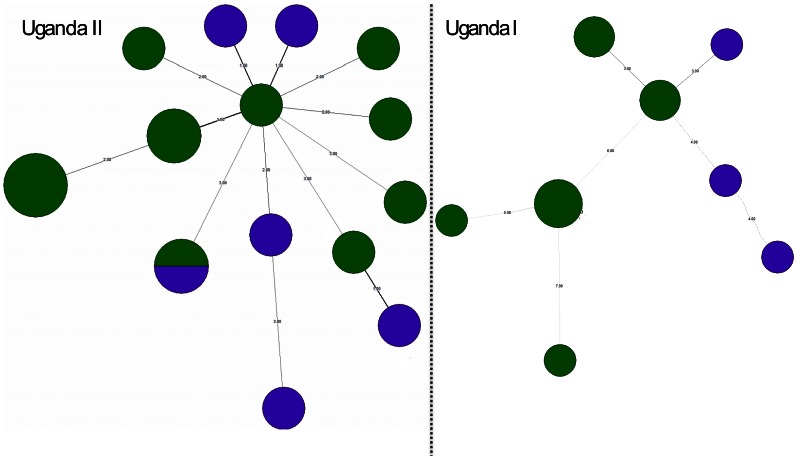
An unrooted minimum spanning tree (MST) showing the molecular relationships of clonal variants of Uganda-I and Uganda-II based on 15 standard MIRU-VNTR loci (Bionumerics 6.1).The purple and green colors represents isolates from urban (Mubende town council and Bagezza) and rural settings (the rest of the sub counties) respectively. In this figure the length and thickness (edged) and steps represent the genetic relatedness between any two connected clonal variants. The size of the nodes (circle) represents the number of isolates of the clonal variants of the T2-Uganda genotypes.